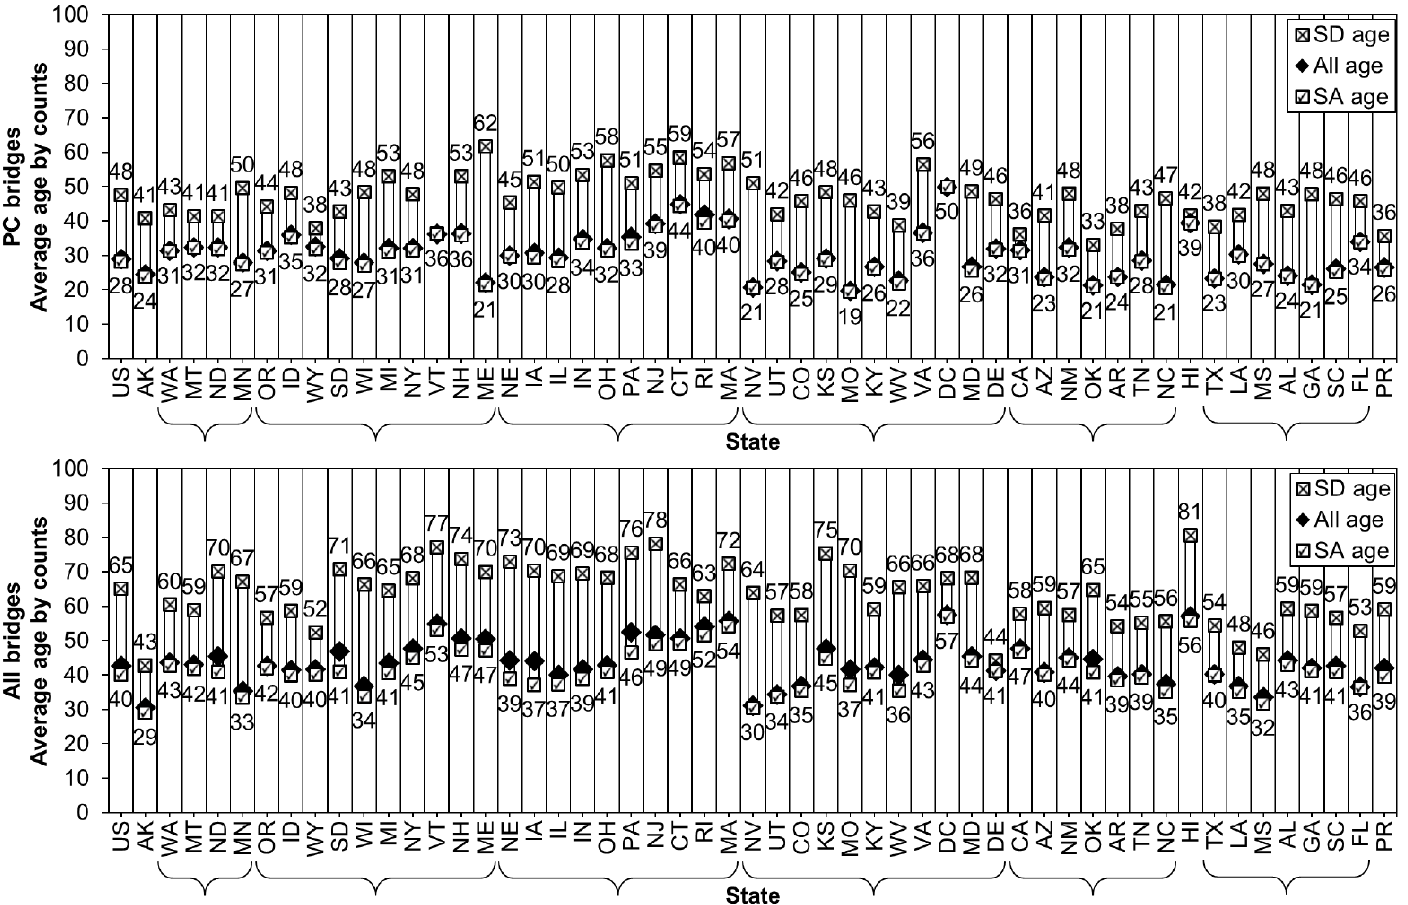
Figure 5. Average age ranges of bridges by state.